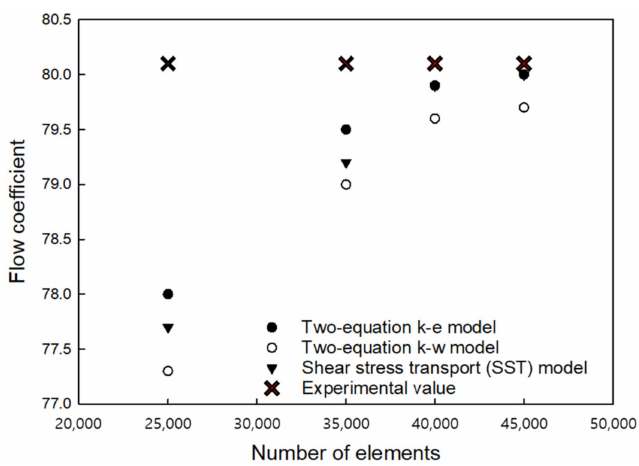
Figure 2. Result of mesh size dependence study for flow